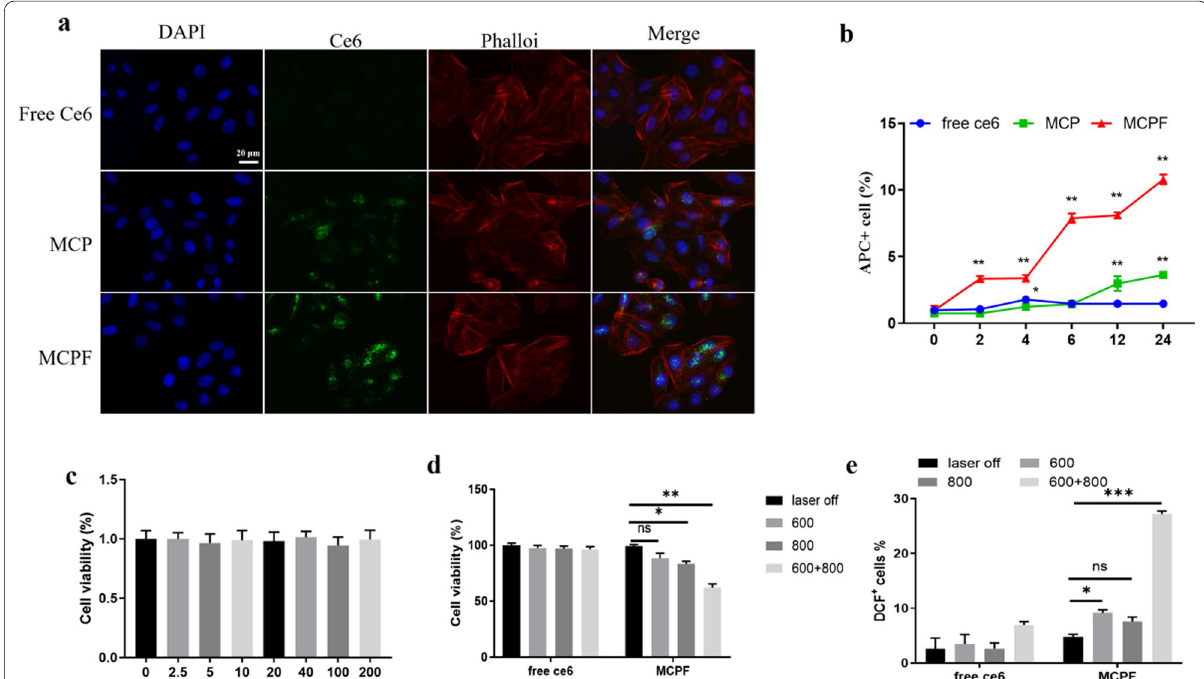
Fig. 3 a–b Confocal fluorescence images ( a ) and flow cytometry data ( b ) of SMMC-7721 cells after incubation with free Ce6, MCP, and MCPF for 4 h. c The cytotoxicity of MCPF on SMMC-7721 cells without laser irradiation. d Cell viability of SMMC-7721 cells treated with free Ce6 or MCPF under single or combined laser irradiation (660 nm at 500 mW cm − 2 and 808 nm at 1.5 W cm − 2 ). e The ROS-producing capability of MCPF NPs detected by flow cytometry using DCFH-DA as an